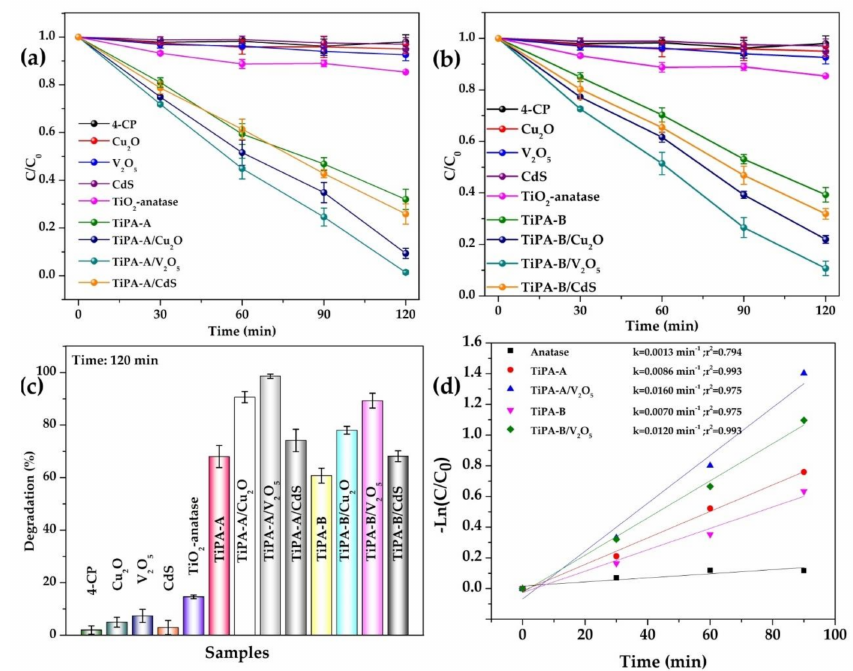
Figure 5. Photocatalytic degradation 4–CP 5 × 10 –5 mol L –1 under simulated solar light irradiation assisted by TiPA and their composites with Cu 2 O, V 2 O 5 , and CdS (Controls: 4–CP and TiO 2 –anatase): Performance (C/C 0 ) of TiPA–A ( a ) and TiPA–B ( b ), based photocatalysts. Rate of photodegradation (%) after 120 min irradiation, assisted by TiPA–A and TiPA–B, alone and by their composites with sensitizers ( c ). Kinetics of photodegradation assisted by TiPA–A and TiPA–B and their composites with V 2 O 5 ( d